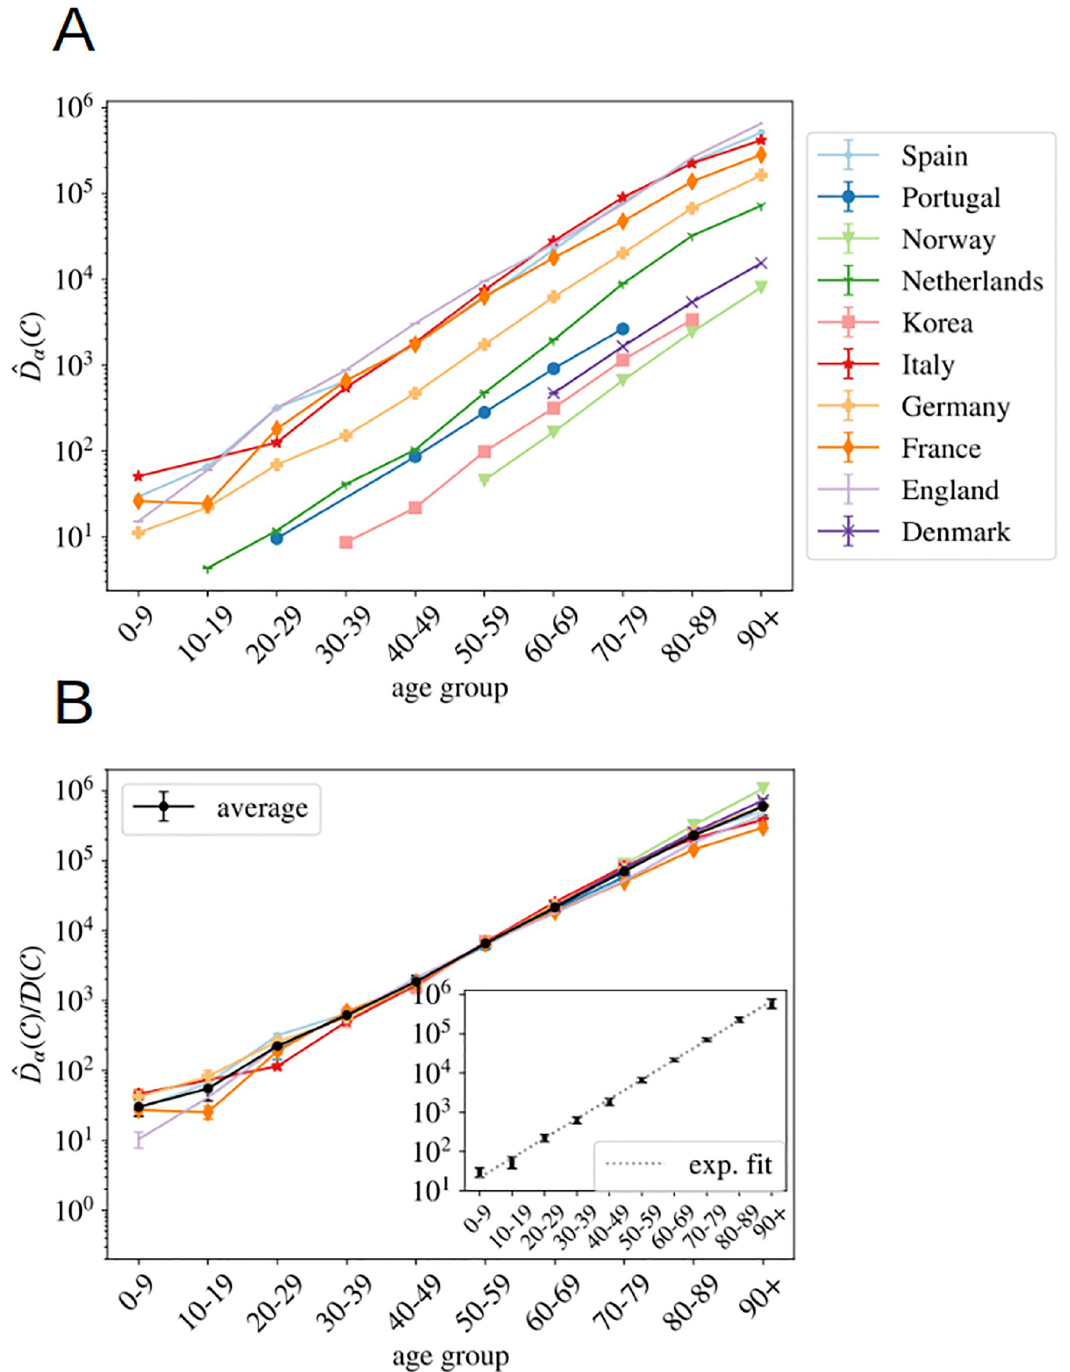
Fig 3. Normalized number of deaths in different countries as a function of age. A We show the normalized number of deaths per age group (defined in Eq (2)) for a selection of countries affected by the COVID-19 epidemic at very different scales. In B , we show the same data (excluding the Netherlands) but where each country has been multiplied by a constant D ð C Þ so that it collapses with the Spanish curve in the age region in between 30 and 70 years old. The values of each country’s constants are given in S2 Table. In black, we show the country average for each age segment (errors calculated with the boostrap method up to a 95% of confidence), and in C the fit of this average to a pure exponential function, see Eq (8).